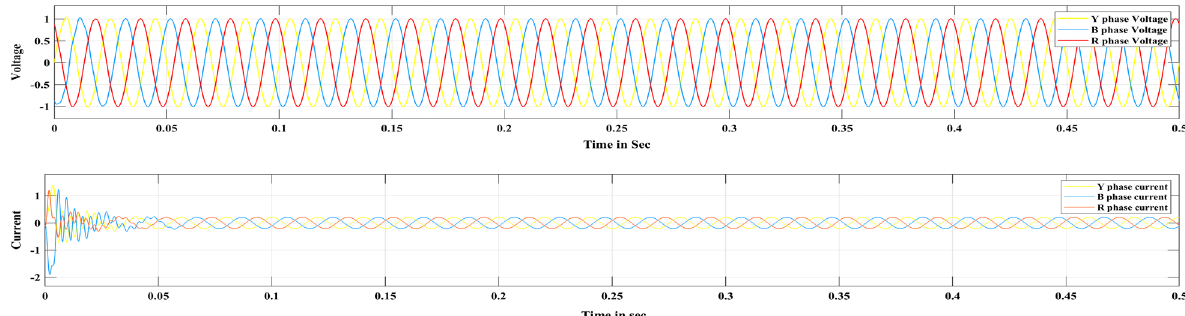
Fig. 12 Voltage and current before enabling the inverter under unfaulty condition